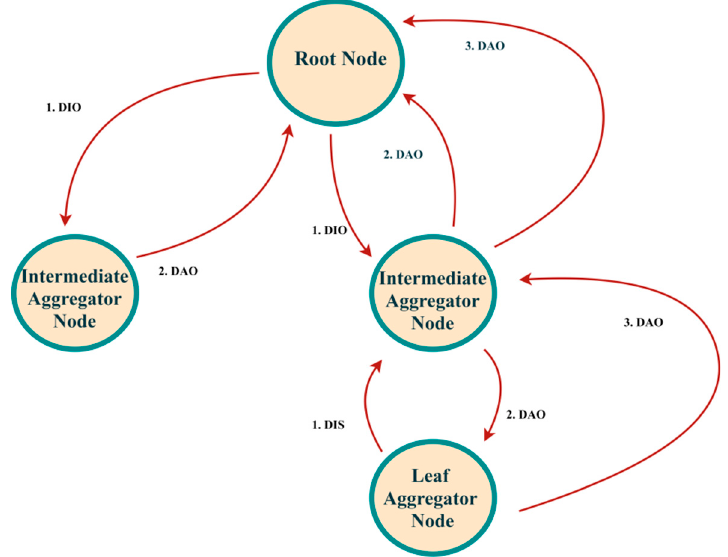
Figure 2. DODAG formation process. Expected Transmission